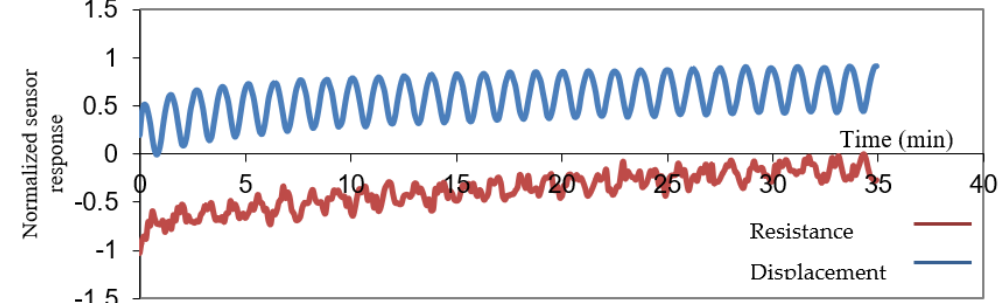
Figure 4. Polarization effect in normalized sensor resistivity response over time (minutes) under low-cycle load in a DC circuit.